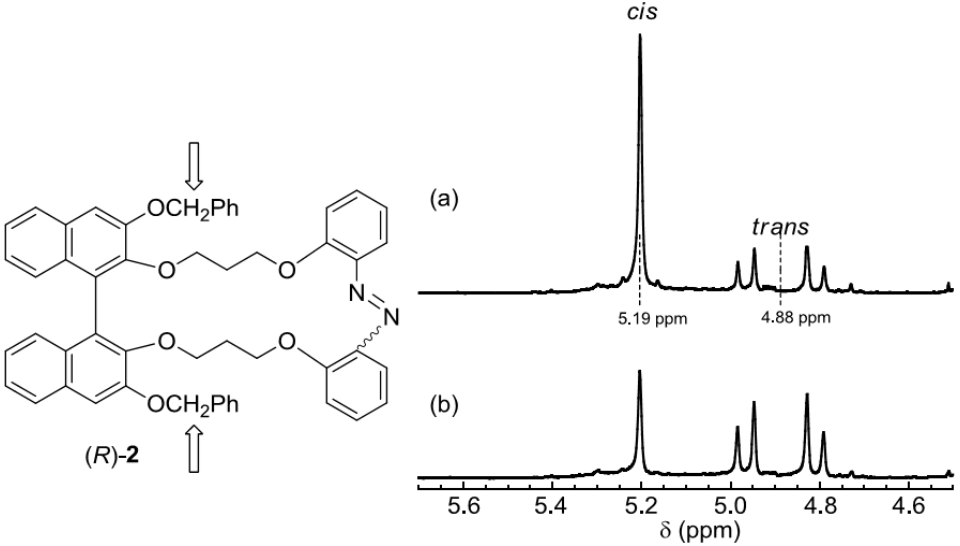
Figure 6. 1 H-NMR spectra of the benzyl protons of ( R )- 2 after (a) 365 nm-irradiation, (b) 436 nm-irradiation. Conditions: CDCl , 1 × 10 − 3 M, 300 MHz, 22 °C, Irradiation: 365 nm 3 (10 mW/cm 2 , 500 s), 436 nm (10 mW/cm 2 , 500 s) in an NMR test tube ( φ = 5